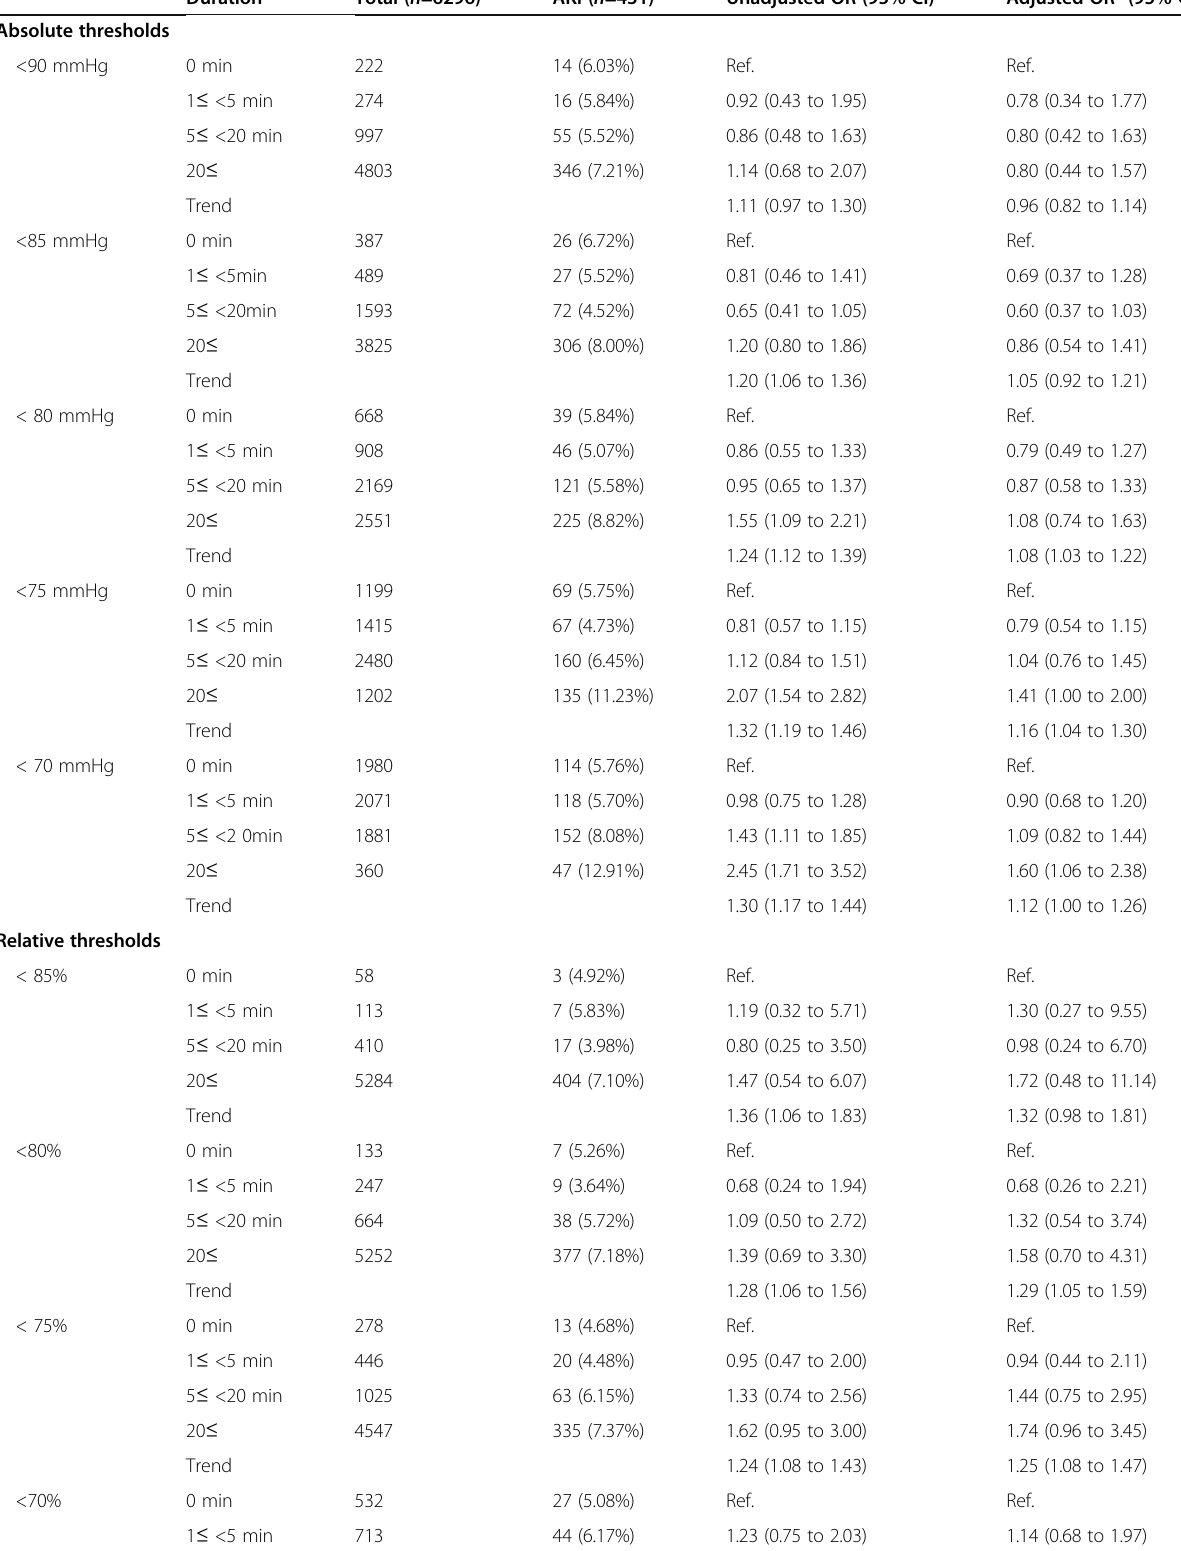
Table 2 Univariable and multivariable associations between absolute or relative thresholds and acute kidney injury ( N =6296) Duration Total ( n